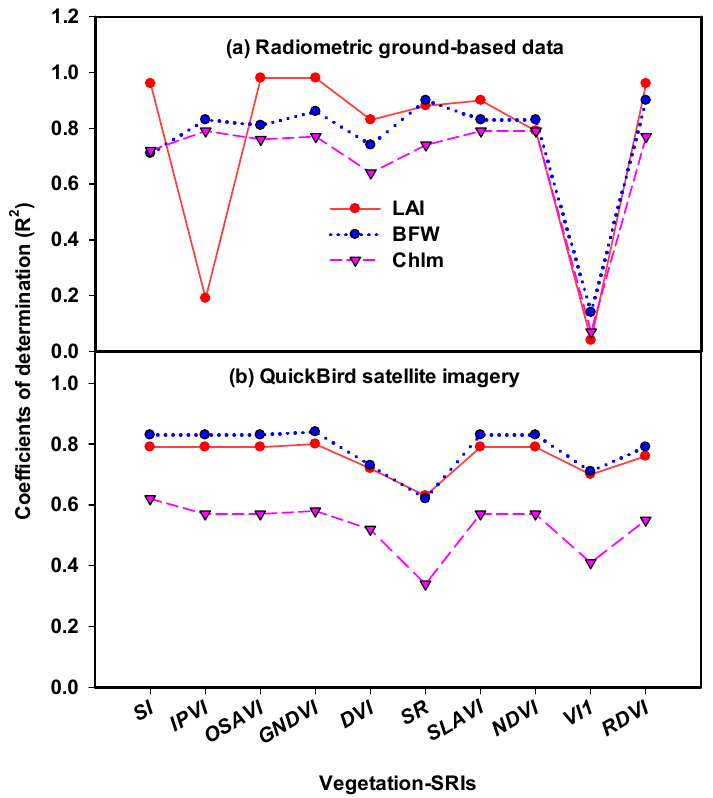
Figure 2. Coefficients of determination (R 2 ) for the relationship between selected spectral reflectance indices (SRIs) in Table 1 extracted from radiometric ground-based data and QuickBird satellite imagery with leaf area index (LAI), biomass fresh weight (BFW) and chlorophyll meter (Chlm) of maize under full irrigated and different stress conditions.